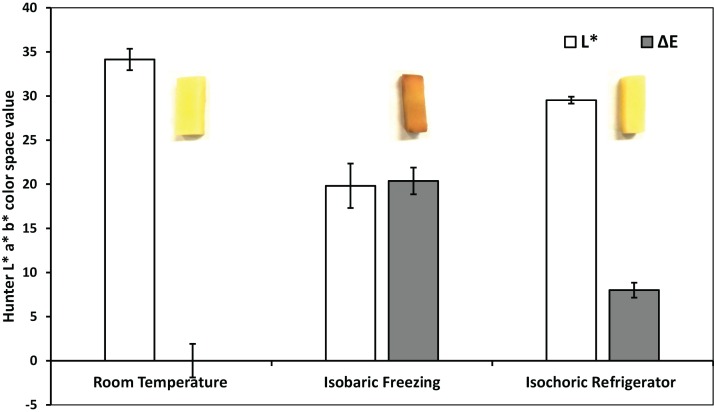
Colorimetric measurements—after room temperature preservation, isobaric freezing and isochoric freezing.ΔE (dark) and L* light data columns. L* represents the lightness of the color (L* = 0 yields black and L* = 100 indicates diffuse white), a* represents the redness and b* represents its yellowness in the color. ΔE is the total color difference which was calculated using \documentclass[12pt]{minimal}
\usepackage{amsmath}
\usepackage{wasysym}
\usepackage{amsfonts}
\usepackage{amssymb}
\usepackage{amsbsy}
\usepackage{upgreek}
\usepackage{mathrsfs}
\setlength{\oddsidemargin}{-69pt}
\begin{document}
}{}$\Delta E = \sqrt {\Delta {L^2} + \Delta {a^2} + \Delta {b^2}} $\end{document}ΔE=ΔL2+Δa2+Δb2, where ΔL, Δa, and Δb are the differences in L*, a*, b* values before and after treatment, respectively, in each sample. The colorimetric experiments were repeated on three samples for each treatment. The values on left are for both, ΔE and L*. The error bars represent the standard deviation of three samples. Inserts, macroscopic photographs of the potato samples.